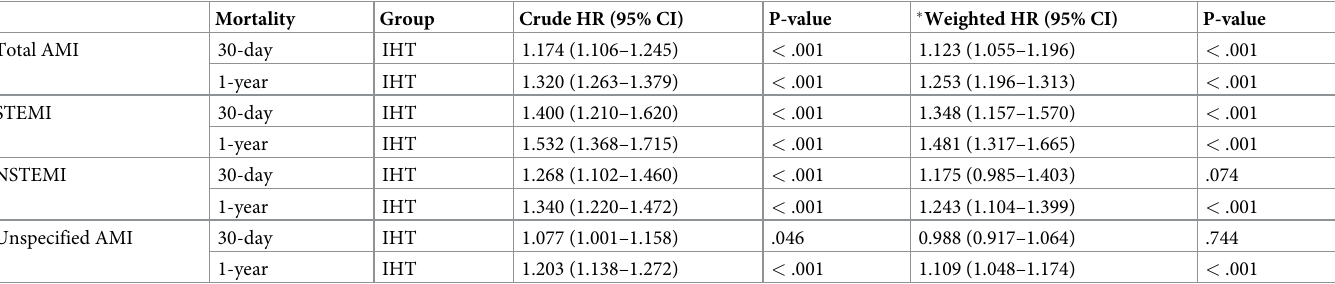
Table 3. Crude and weighted hazard ratios of transfer on the short- and long-term mortality after balancing comorbidity and demographic characteristics.